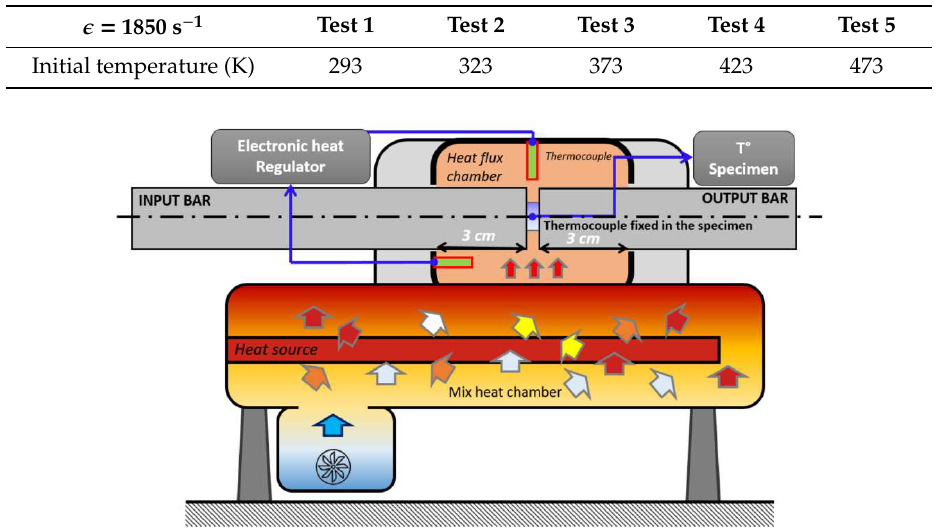
Table 10. SHPB test conditions for a constant strain rate (1850 s −1 ).